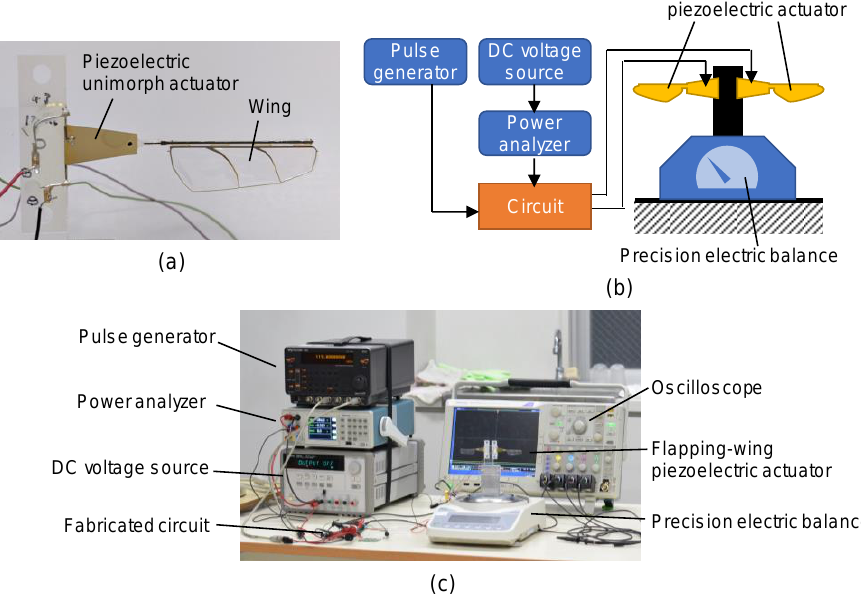
Figure 8. Samples and setup: ( a ) flapping-wing actuator; ( b ) schematic and ( c ) photograph of measurement setup.